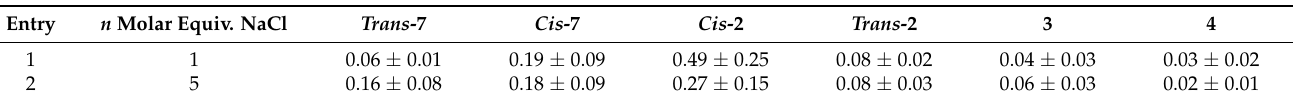
Table 4. Product yields from the conversion of CHN 1 with varying equivalents of NaCl in 8% D 2 O/DMSO- d 6 . Yields are reported as averages and standard deviations obtained from triplicate